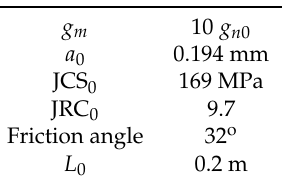
Table 3. Penalty stiffness properties of the joint based on geo-mechanical